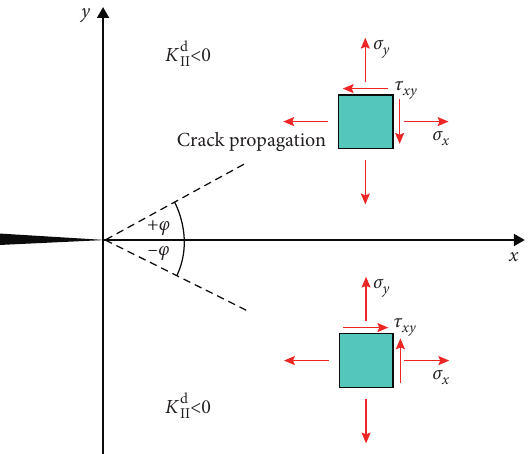
Figure 10: Schematic diagram of stress under different deflection of plane crack.